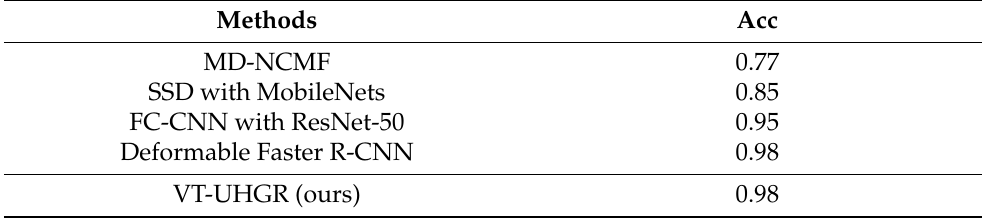
Table 3. Quantitative comparison of two-stage methods on the CADDY